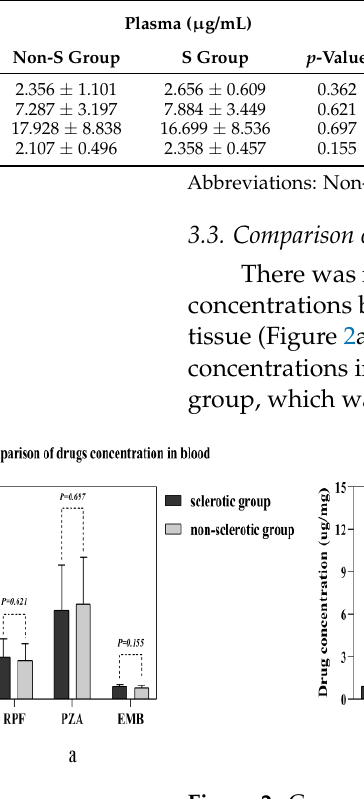
Figure 2. Comparison of four drug concentrations in different samples between the two groups: ( a ) the concentration comparison in blood; ( b ) the concentration comparison in normal tissue; ( c ) the concentration comparison in focus tissue. Abbreviations: isoniazid (INH), rifampin (RPF), pyrazinamide (PZA), and ethambutol (EMB). The independent samples t -test was used in making the comparison. “*” means statistic significance.